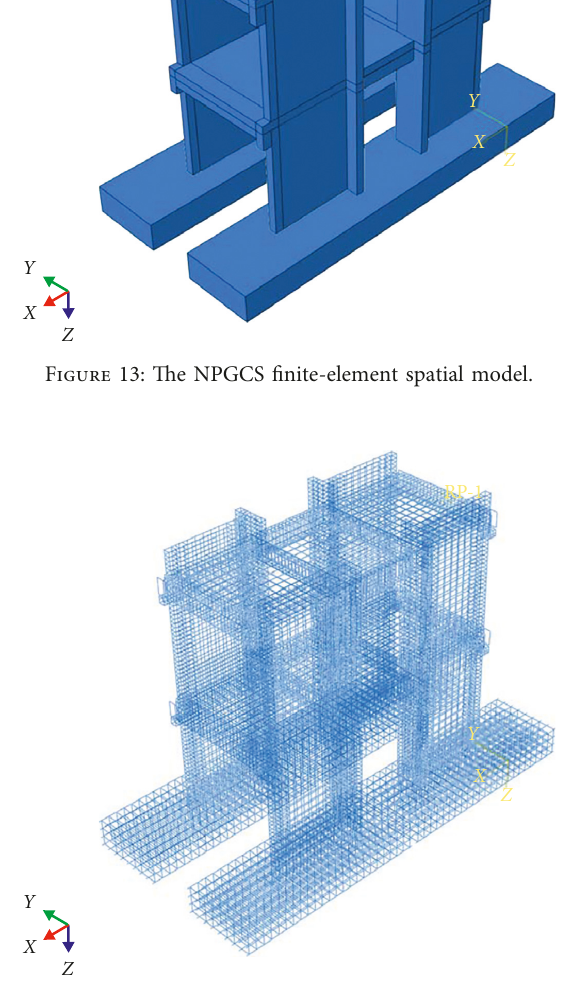
Figure 14: The steel bars of NPGCS finite-element spatial Table 2: Strengths of the NPGCS spatial model.